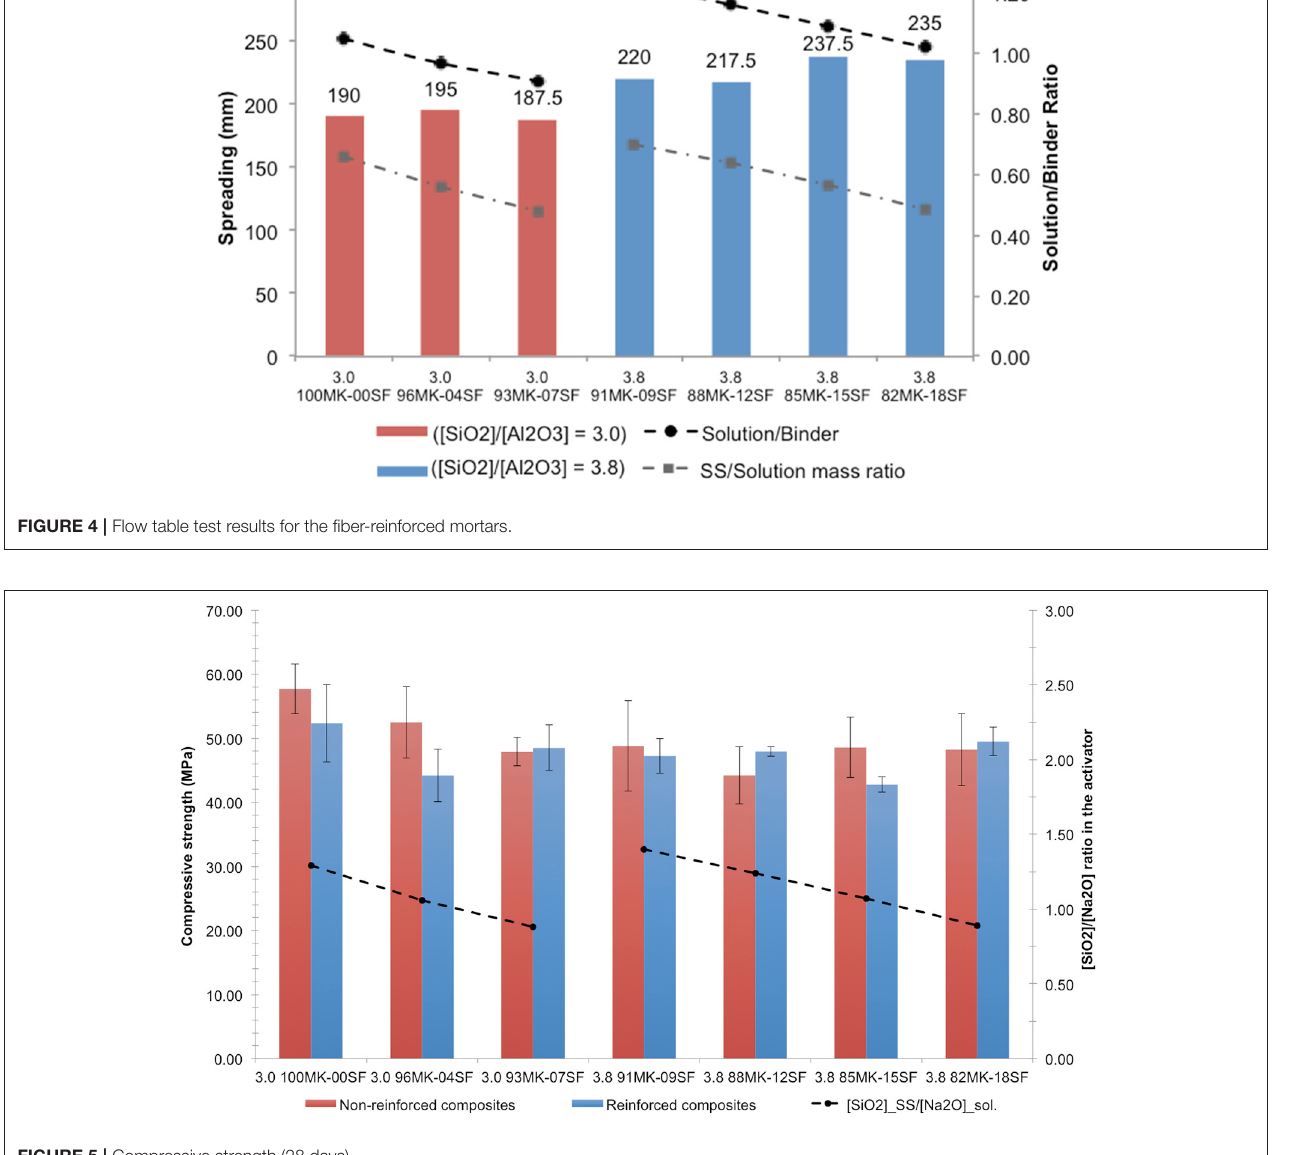
FIGURE 5 | Compressive strength (28